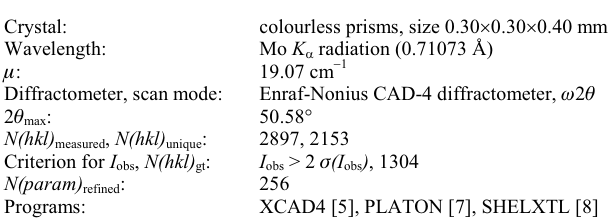
Table 2. Atomic coordinates and displacement parameters (in Å 2 )